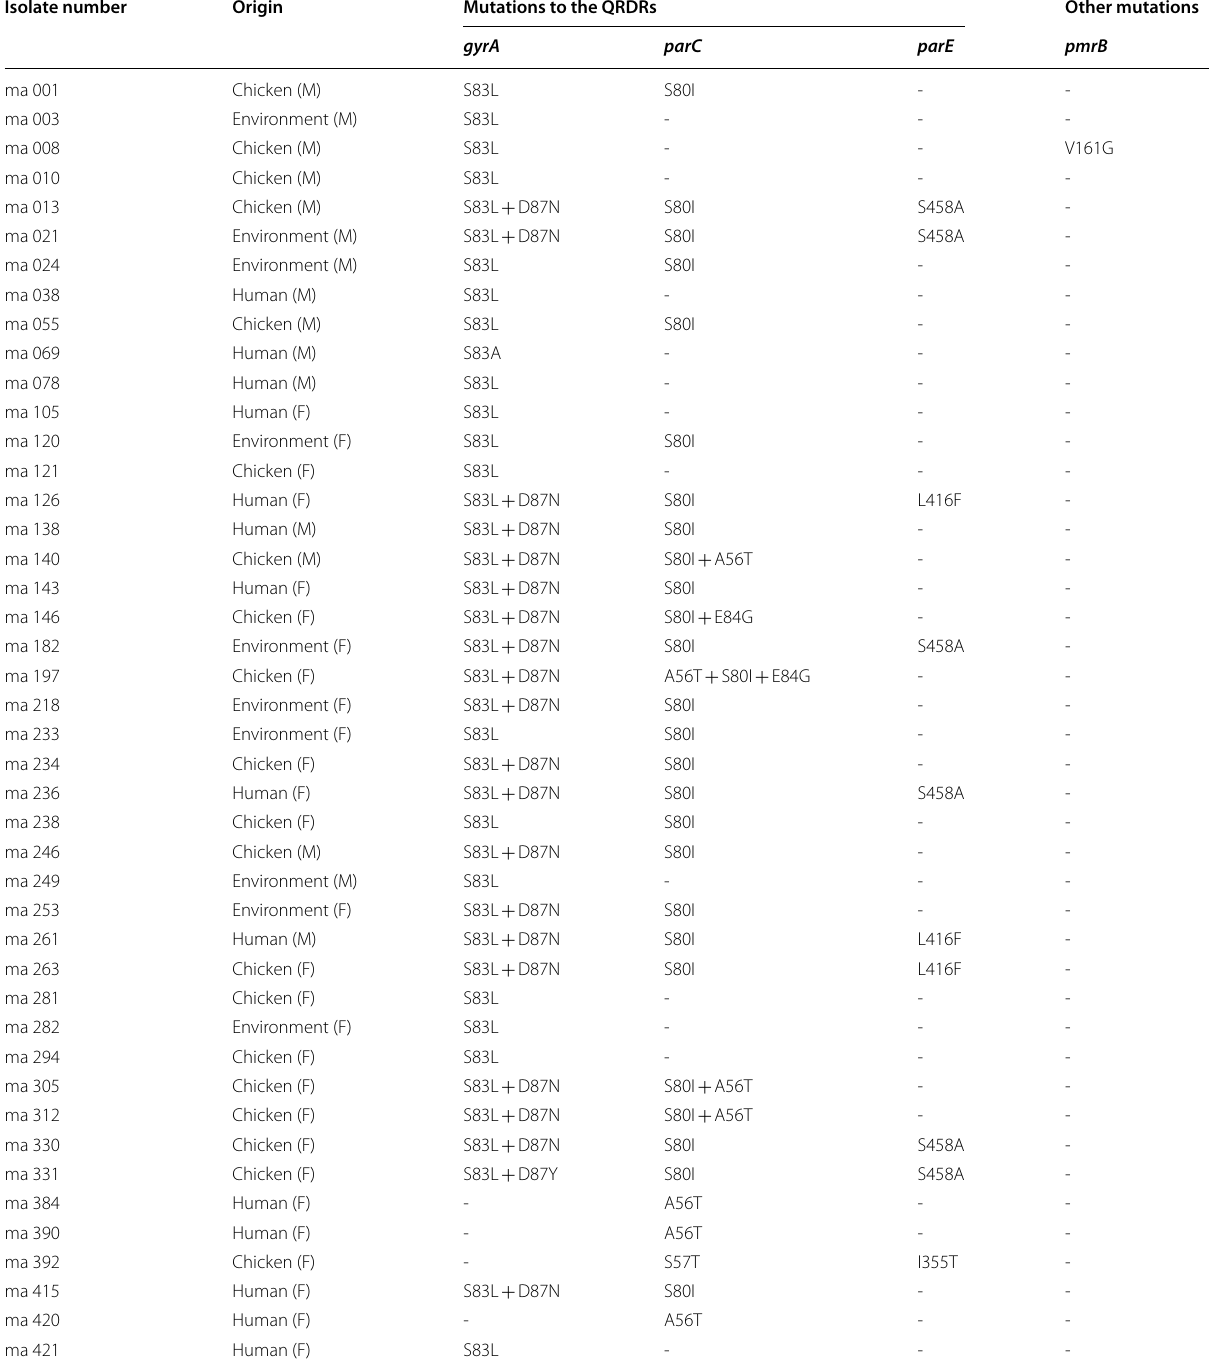
Table 3 Characterization of 43 nalidixic acid-resistant Escherichia coli isolates from humans, chickens, and poultry farm/market